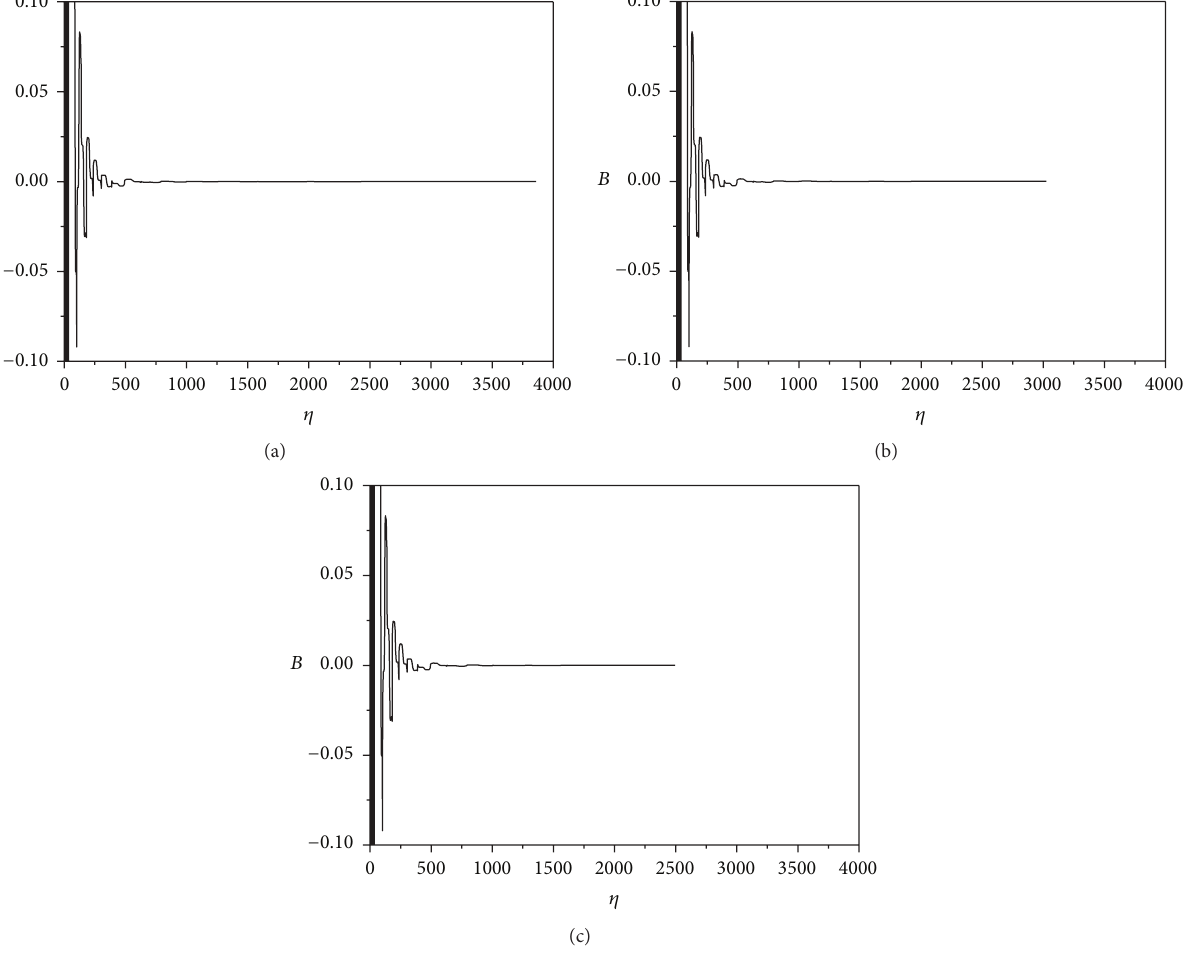
Figure 3: The evolution of the baryon charge 𝐵(𝜂) for 𝜆 1 = 5×10 −2 , 𝜆 2 = 𝜆 3 = 10 −2 , 𝛼 = 5×10 −2 , 𝐻 = 10 11 GeV, 𝜑 𝑜 = 𝐻 𝐼 𝜆 −1/4 , and ̇𝜑 𝑜 = 𝐻 𝐼2 . (a) Curve is for 𝑚 = 100 GeV, (b) for 𝑚 = 200 GeV, and (c) for 𝑚 = 350 GeV.